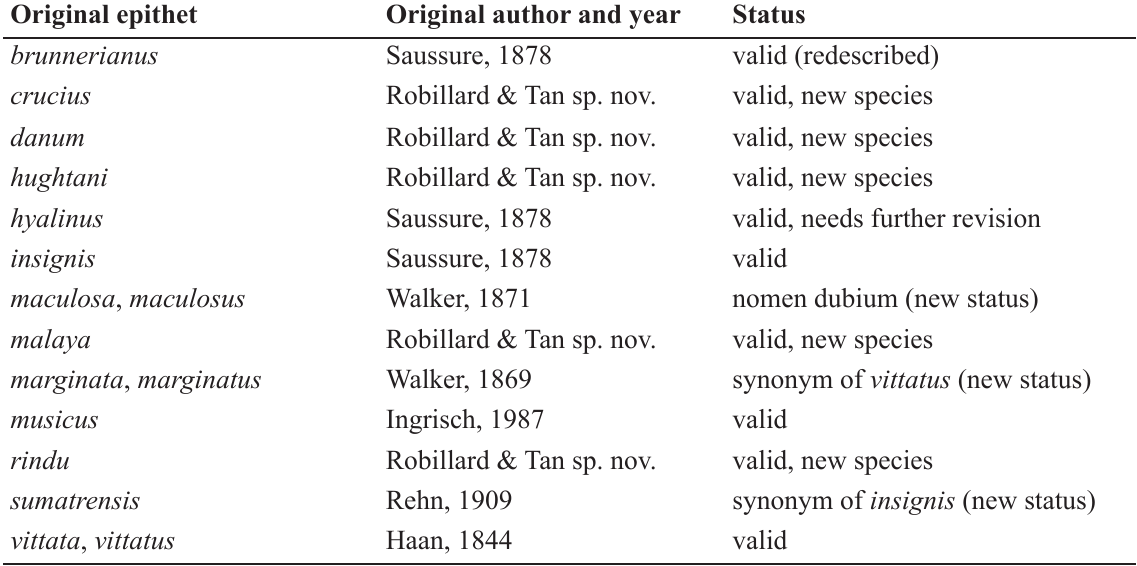
Table 2. Status of original species epithets associated with Nisitrus Saussure, 1878 .